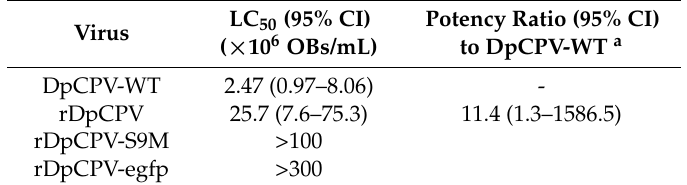
Table 2. Infectivity of wild-type and rescued DpCPVs against third-instar S. exigua larvae.